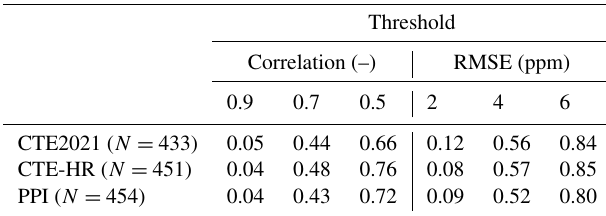
Table 6. Fraction of the station months over all stations ( N = 46) for 2018 with a better statistical score than the threshold given in the header. The days with the highest and lowest 2.5% RMSE are discarded to remove events that are not captured by TM5, resulting in different numbers of site months for the different